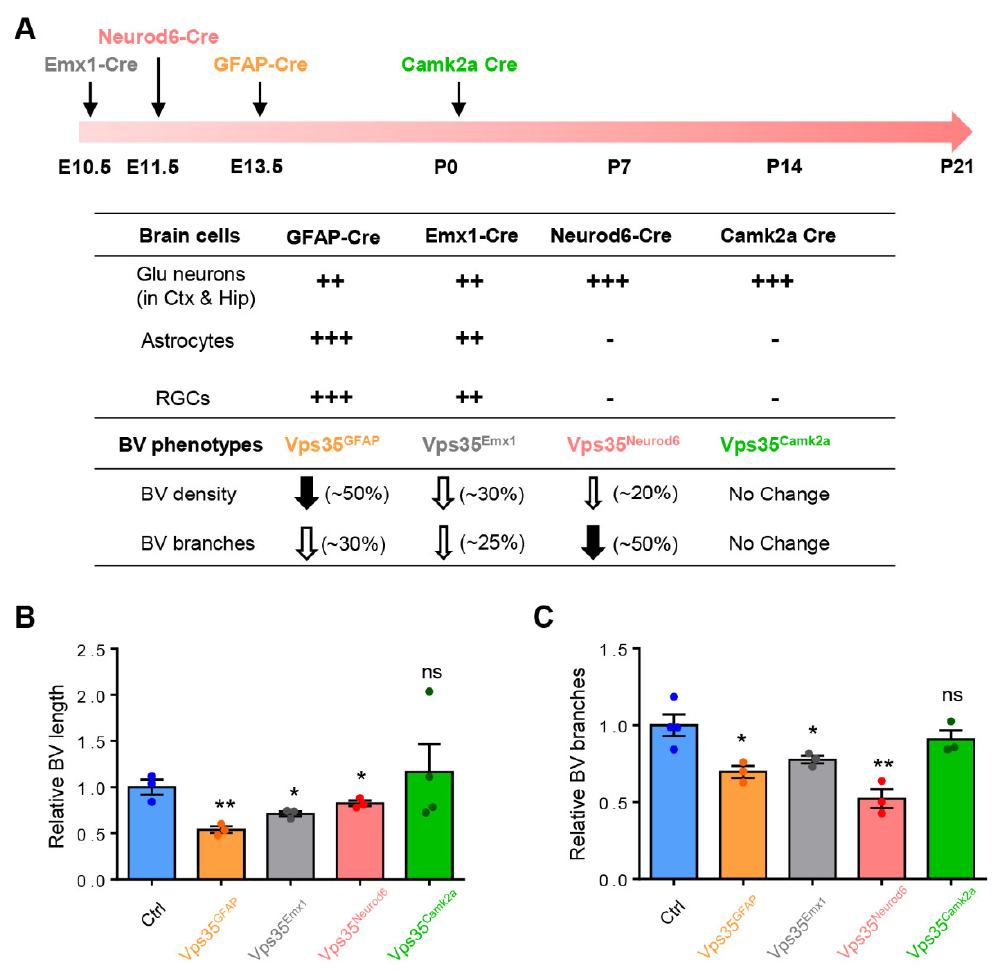
images of the boxed regions of D and BV. ( F ) Quantification of PECAM-1 + vessel length and BV branches in E (n = 3 mice per genotype; two-tailed unpaired t test). ( G ) Representative images of blood vessels (BVs) in the hippocampus of control and Vps35 Neurod6 mice at an age of P14. Brain sections were subjected to immunostaining analysis using PECAM-1 antibodies (red); the nuclei were stained with DAPI (blue). ( H ) Higher-magnification images of the boxed regions of G and BV. ( I ) Quantification of PECAM-1 + vessel length and BV branches in H (n = 3 mice per genotype; two- tailed unpaired t test). Scale bars as indicated in each panel. Individual data points are shown as dots with group mean ± SEM; ** p < 0.01; *** p < 0.001; **** p < 0.0001.